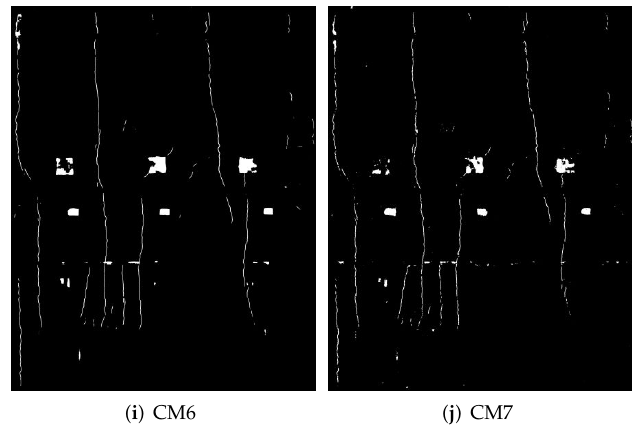
Figure 6. Results of proposed method and comparative methods. (From left to right: ( a ): original image; ( b ): ground truth; ( c ): results obtained by the proposed method; and ( d – j ): results obtained by the comparative methods.)